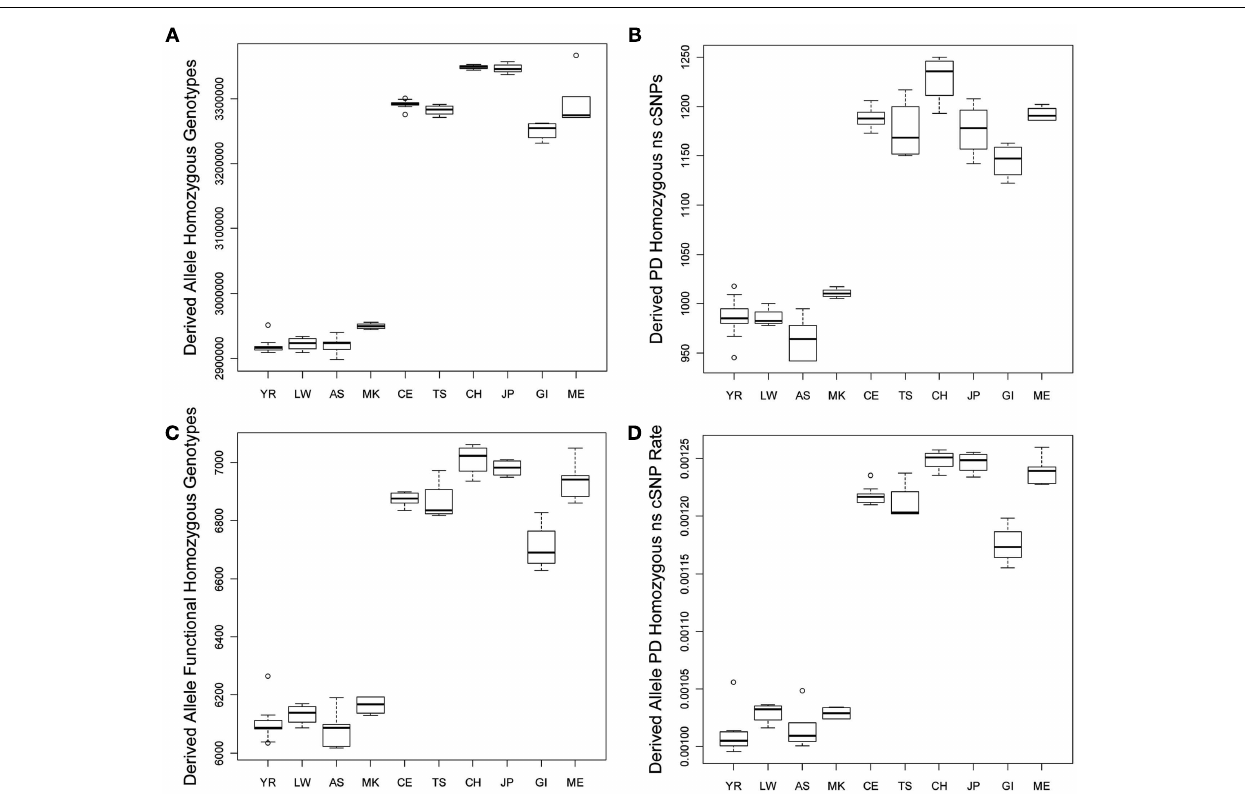
have functional effect. (C) Number of loci on individual genomes that are homozygous for a derived allele that is predicted to have a functional effect; (D) The rate of loci on individual genomes that are homozygous for a derived allele that is predicted to have a functional effect (relative to all loci on individual genomes with at least one derived